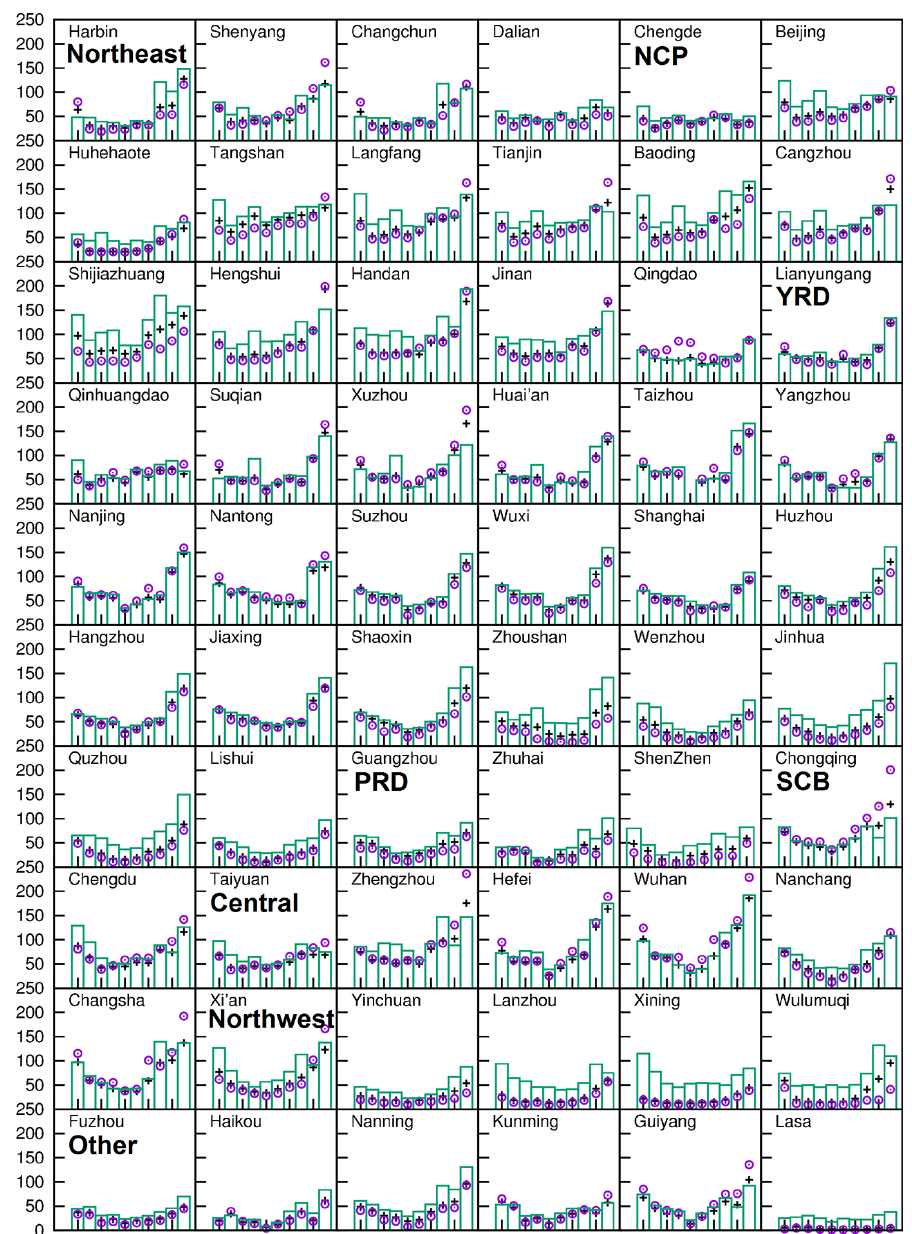
Figure 4. Comparison of predicted (in column) and observed (in circle) monthly averaged PM 2 . 5 concentrations for March to December 2013. The “best” symbols (in “ + ”) represent predictions closest to the hourly observations within a 3 × 3 grid cell region with the grid cell where the monitoring sites are located at the center. Units are µgm − 3